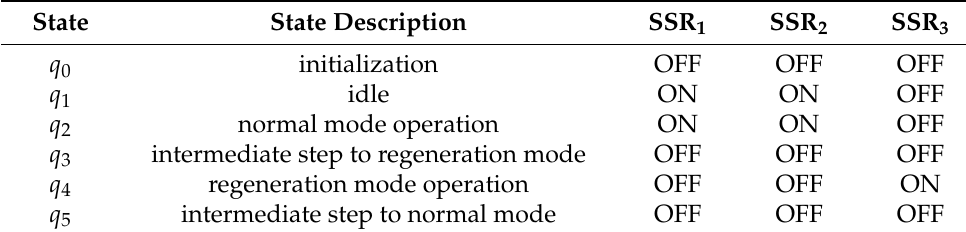
Table 1. Description of the FSM states along with the respective state of the SSRs.